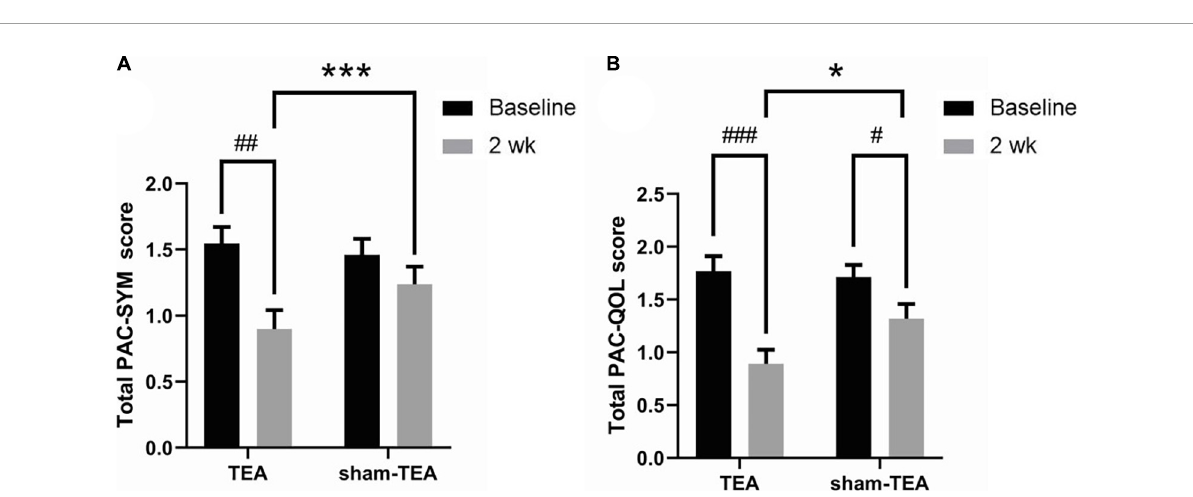
FIGURE2 Effects of TEA on the PAC-SYM and the PAC-QoL. The total PAC-SYM score (A) and total score of PAC-QoL (B) in TEA group and sham-TEA group after 2 weeks of treatment (vs baseline, # P < 0.05, ## P < 0.01, ### P < 0.001; vs sham-TEA, * P < 0.05, *** P <